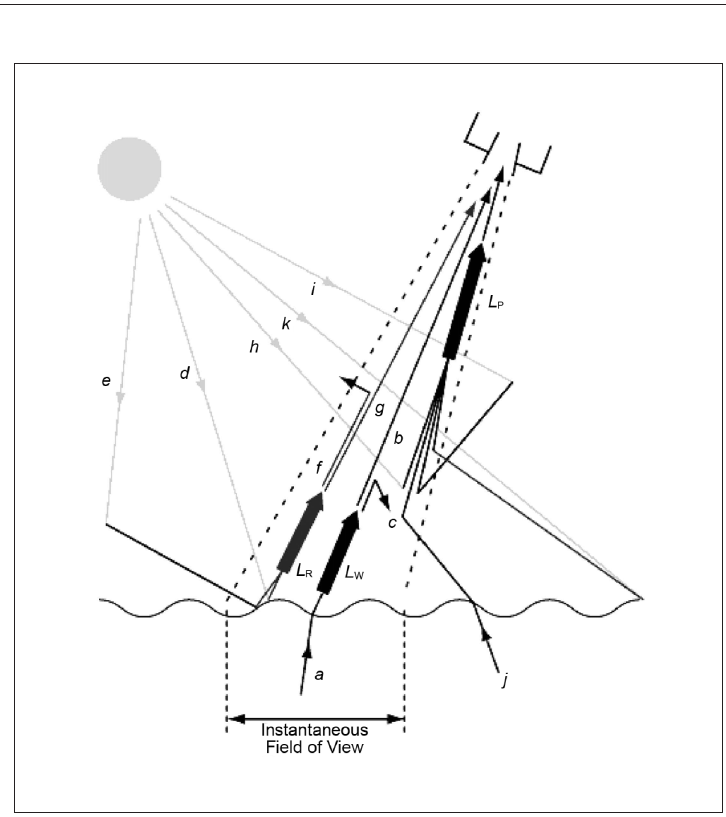
Fig. 2. Several different light pathways in the atmosphere are illustrated. L W is the total water-leaving radiance. L R is the radiance above the sea surface due to all surface reflection effects within the IFoV ( L SKYG , L WC and L SUNG ). L P is the atmospheric path